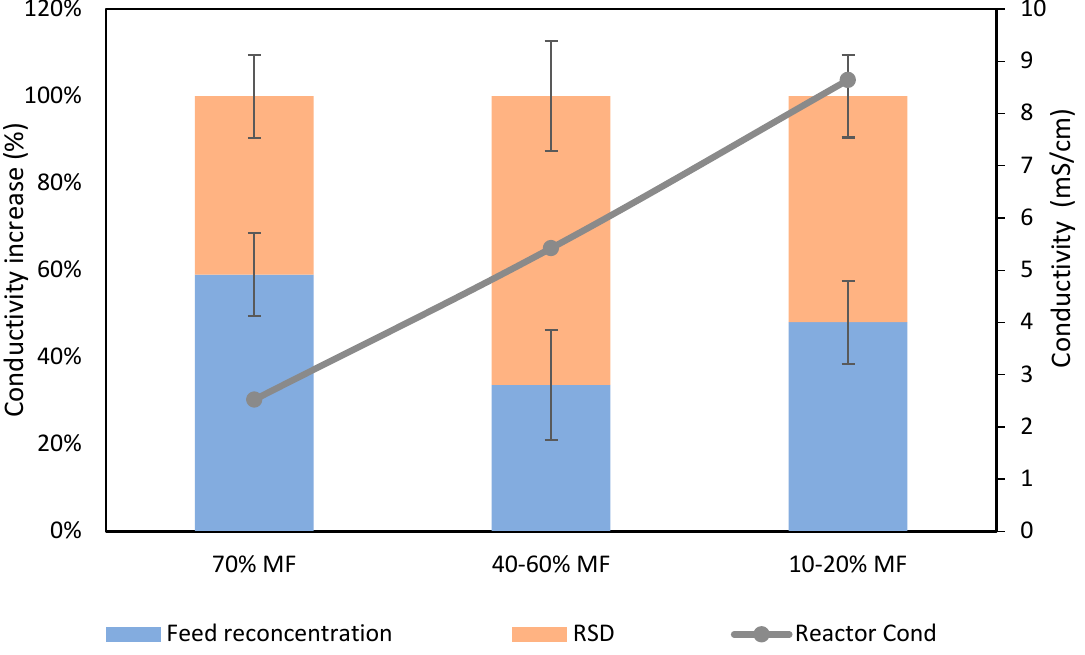
Figure 3. Respective impact of RSD and feed salts concentration on conductivity increase in the G-AnOMBR reactor for each MF/FO ratio.